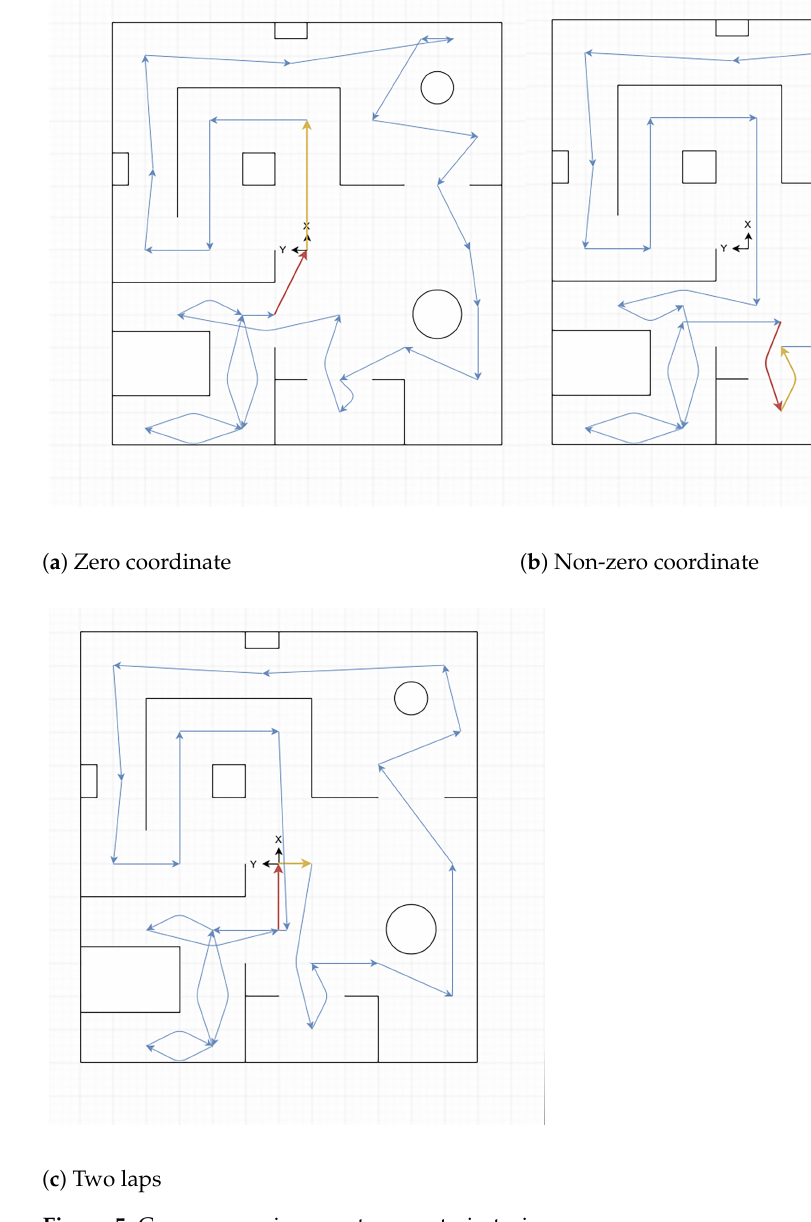
Figure 5. Common environments arena